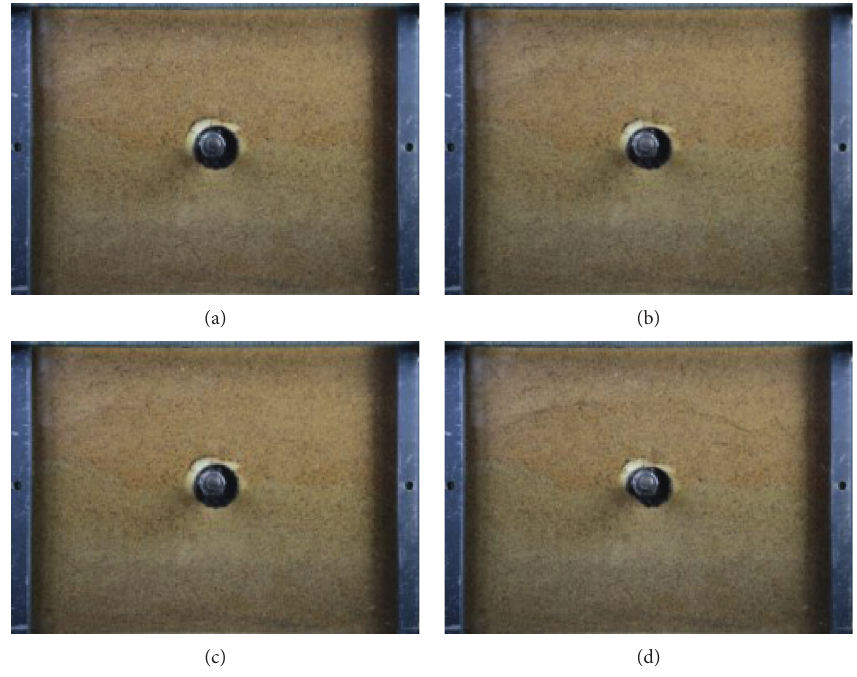
Figure 16: Main test image with support model. (a) 0.25MPa. (b) 0.48MPa. (c) 0.58MPa. (d)